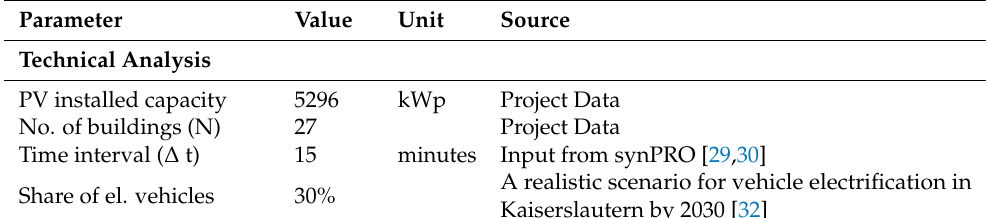
Table 3. Inputs to the REC Assessment Model.